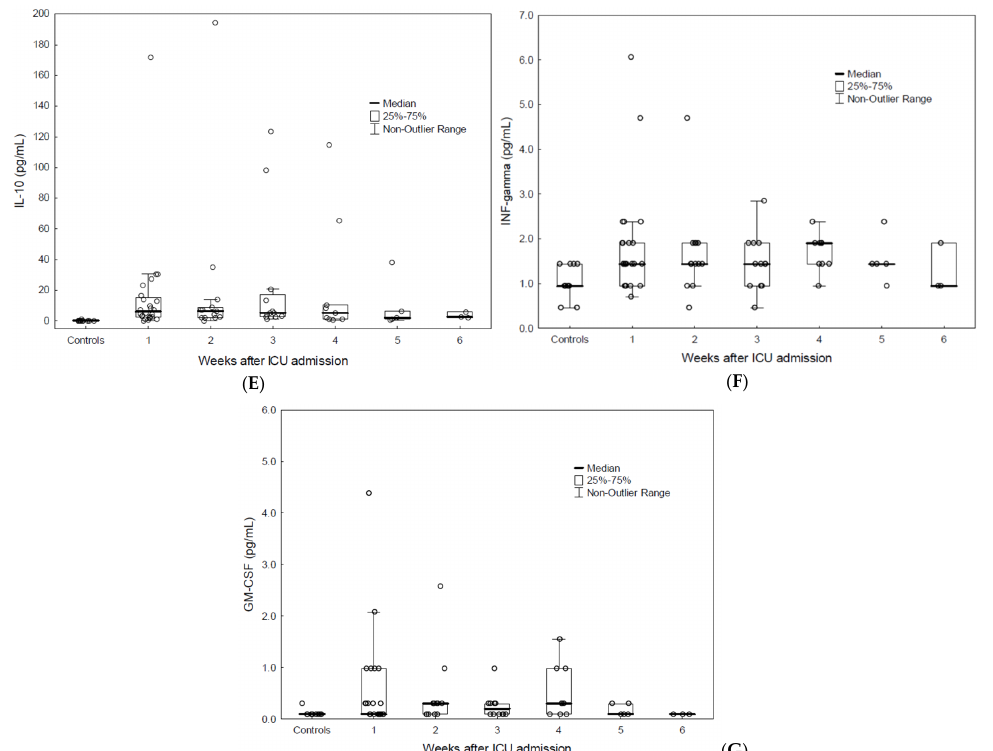
Figure 2. Weekly plasma cytokine levels in ICU patients with severe COVID-19 compared to in HCs. Levels of TNF α , IL-2, -6, -8, and -10 ( p < 0.001), IFN- γ ( p < 0.01), and GM-CSF ( p < 0.05) were higher in COVID-19 patients compared to in HCs: ( A ) TNF α -levels; ( B ) IL-2 levels; ( C ) IL-6 levels; ( D ) IL-8 levels; ( E ) IL-10 levels; ( F ) IFN γ levels; ( G ) GM-CSF levels. Due to a few values for weeks 2–6, statistical analysis was only performed for the first ICU week. 3.4. FCM Markers and Circulating Cytokine Levels Related to Organ Failure and Mortality There was no correlation between the measured surface markers, intracellular cyto- kines and PaO 2 /FiO 2 ratio. However, for patients with PaO 2 /FiO 2 ratios less than 13.3 kPa vs. patients with better respiratory function and PaO 2 /FiO 2 ratios of ≥ 13.3 kPa, the mye- loid marker CD33 (89.9 ± 7.8% vs. 84.6 ± 2.2%) and plasma IL-6 levels (234.0 ± 518.9 vs. 2.3 ± 1.7 pg/mL; p < 0.05) were higher in the former. Levels of IL-2, IL-4, IL-6, IL-8, IL-10, and TNF α in the first ICU week were higher in patients who were treated with CRRT during their ICU admission ( p < 0.05). The levels of the maximum plasma creatinine and circulating TNF α Spearman’s rank-order correla- tion coefficient (rho = 0.51, p < 0.05) and IL-8 (rho = 0.44, p < 0.05) correlated (Table 3). CD14 expression was lower during the first ICU week among patients who devel- oped ICUAW ( p < 0.05). CD14 expression was not associated with the length of stay in the ICU. There were no differences in surface CD markers and circulating cytokine levels between patients who survived for 30 days after ICU admission and non-survivors. Table 3. The Spearman’ rank correlation coefficients for arterial oxygen partial pres- sure-to-fractional inspired oxygen (PaO 2 /FiO 2 ) ratios in kPa in the third column and Krea max in mmol/L in the right column correlated with CD markers, intracellular (prefix c) and plasma cyto- kine. All values were obtained during the patients first week of ICU admission. Variables PaO 2 /FiO 2 PaO 2 /FiO 2 Krea max Krea max n Spearman R n Spearman R CD2+ 15 − 0.053 20 0.27 CD4+ 17 − 0.045 23 0.025 CD8+ 0.28